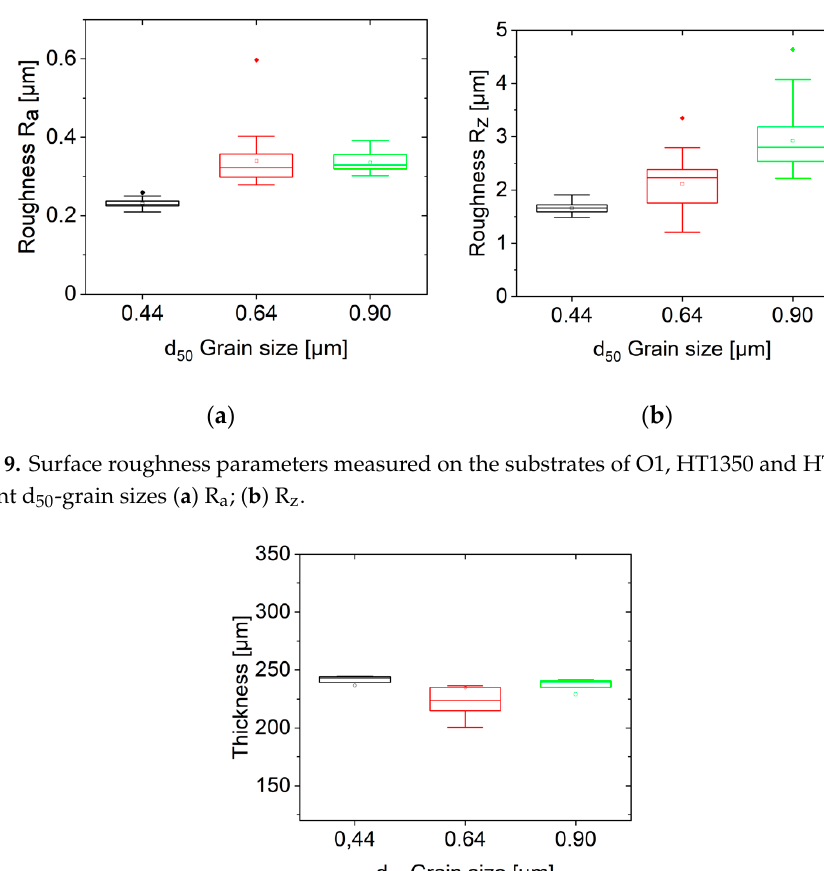
( c ) Figure 8. Field emission scanning electron microscopy (FESEM) images of the as-cut substrate surfaces of the sample: ( a ) O1; ( b ) HT1350; ( c ) HT1400. The changed surface morphology of the substrates is also documented in the increased roughness values (Table 2, Figure 8a,b) and the decreased biaxial strength (Table 2). The roughness measurements parallel (R ||) and perpendicular to the wire movement direction (R ⊥ ) show no significant differences (Table 2). Therefore, the mean values include the values of both directions. The